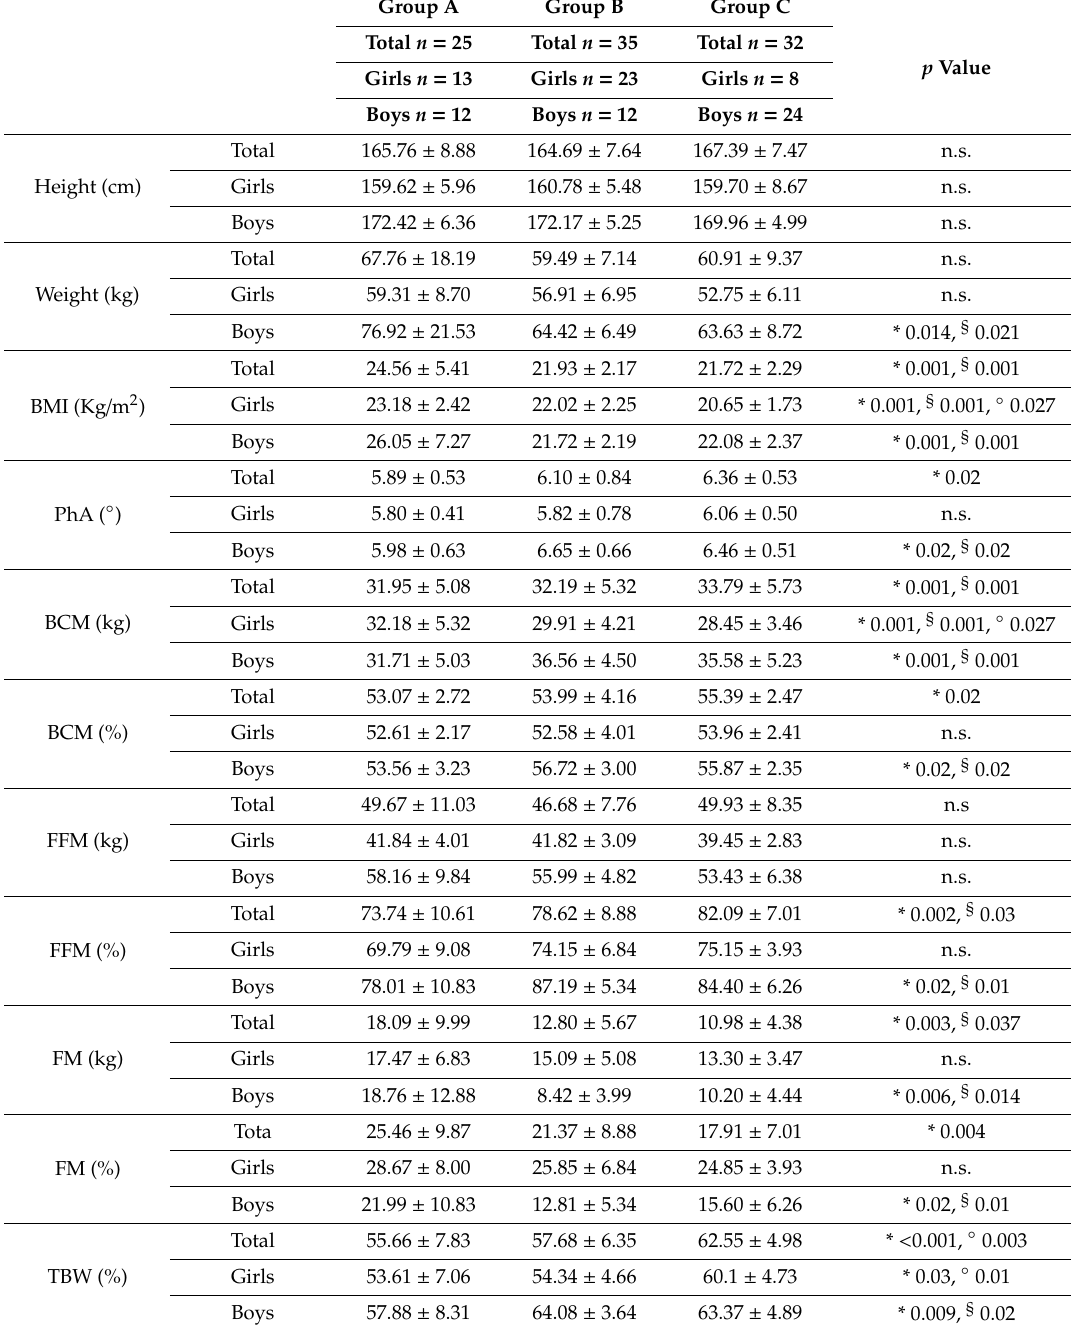
Table2. Bodycompositionaccordingtothreephysicalactivitygroupsinallthesampleanddi ff erentiated by